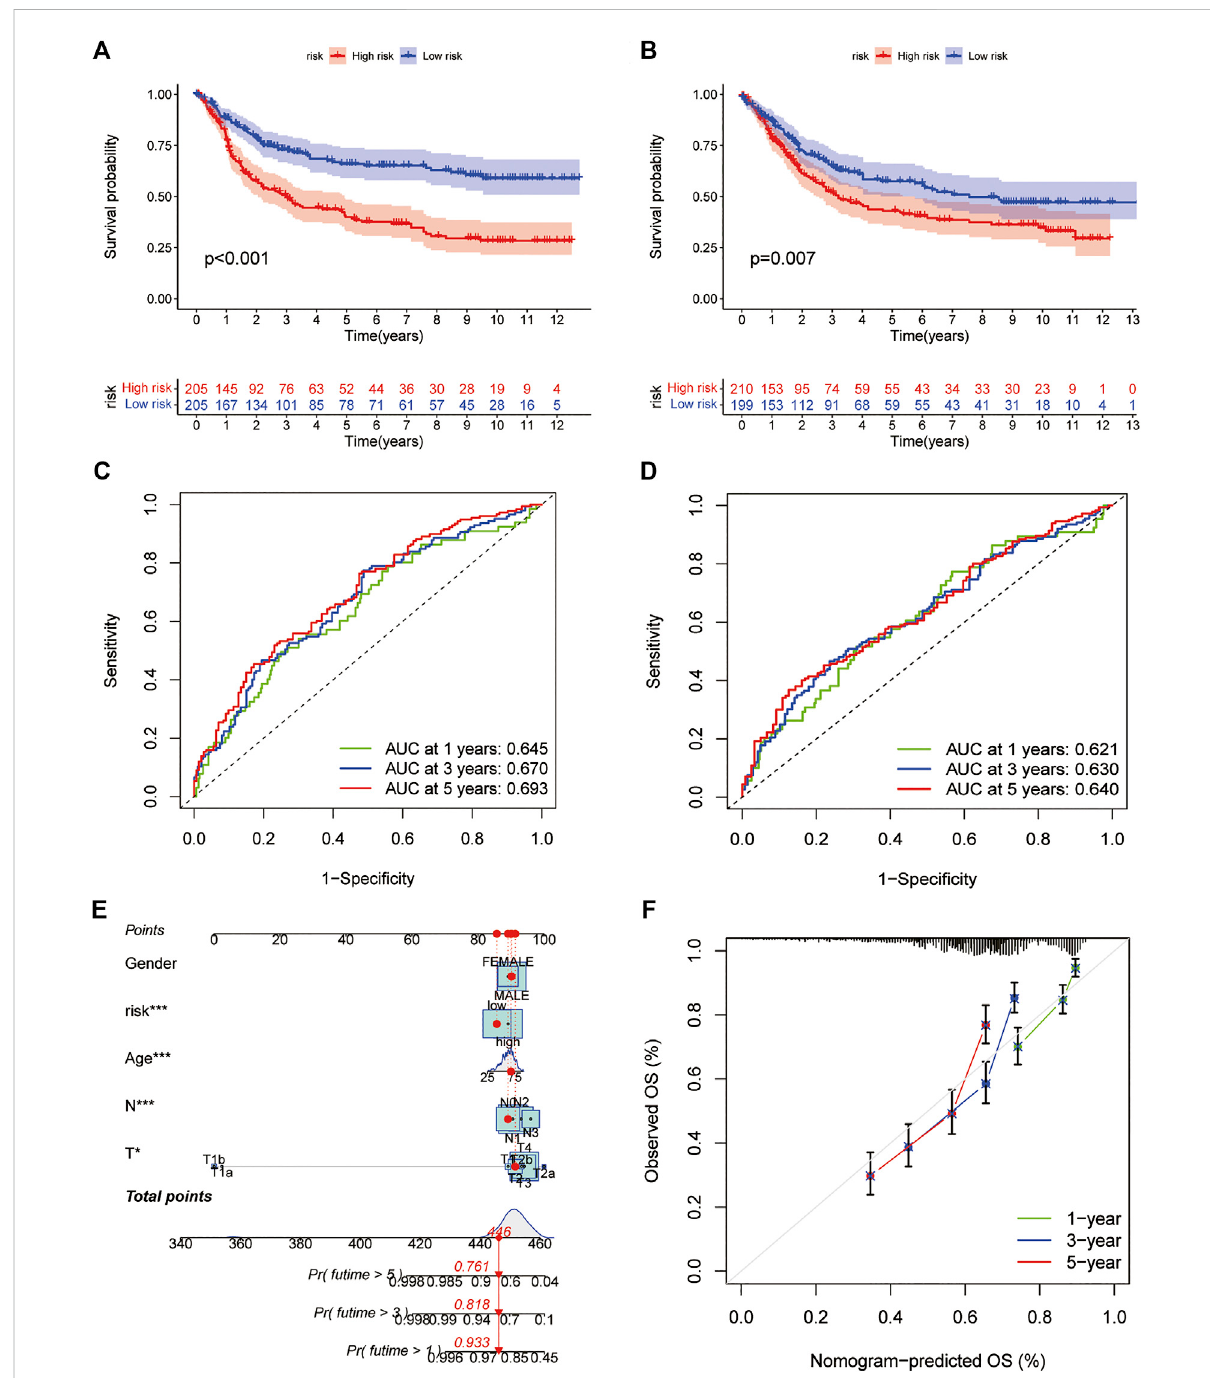
FIGURE 6 Prediction model (A,B) Kaplan-Meier survival curves between the high- and low-risk groups in the training and test cohorts (C,D) ROC curves predicting 1-,three- and 5-years OS in thetraining and testcohorts ofGCpatients (E) Nomogram forpredicting the1-,three- and 5-years OS ofGC patients (F) Calibration curves of the nomogram. ROC: receiver operating